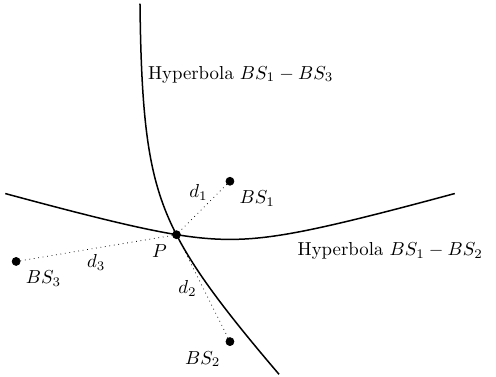
Figure 4. Range-difference measurement based positioning with at least 3 BS.